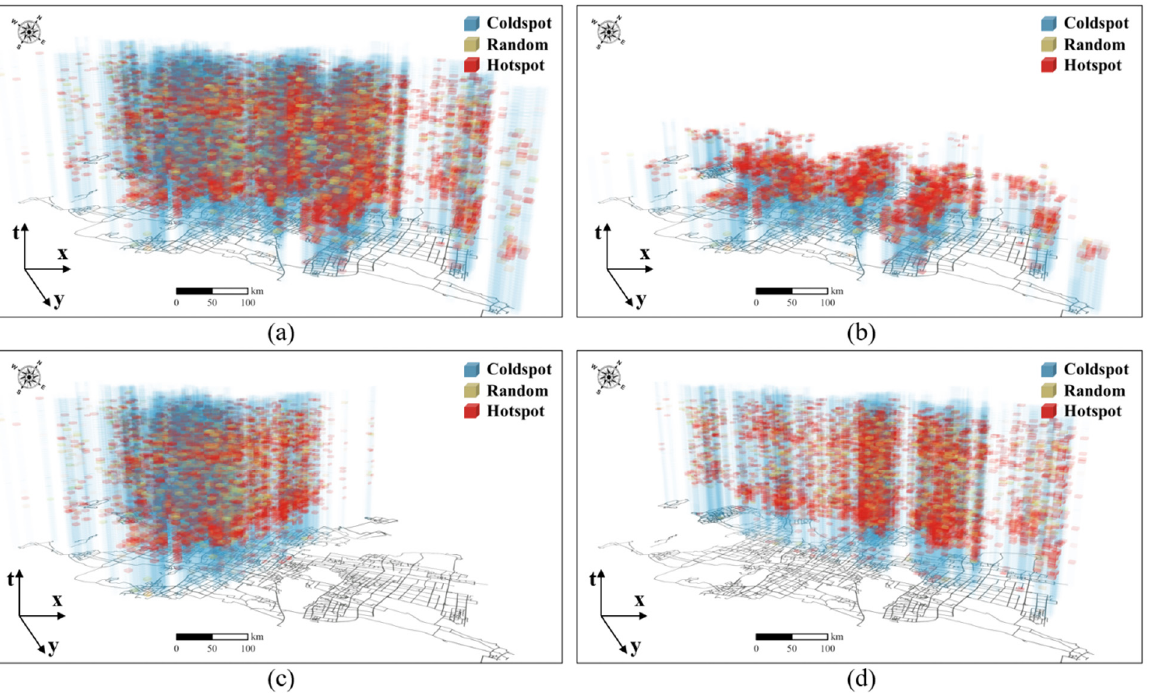
Figure 8. Space-time heterogeneity of cycling rhythm. ( a ) overall distribution; ( b ) time cross-section; ( c ) north-south longitudinal section; ( d ) east-west longitudinal section.